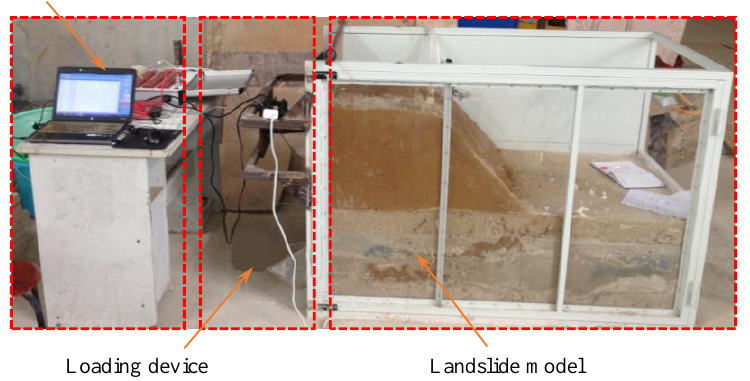
Figure 1. Landslide test model framework.